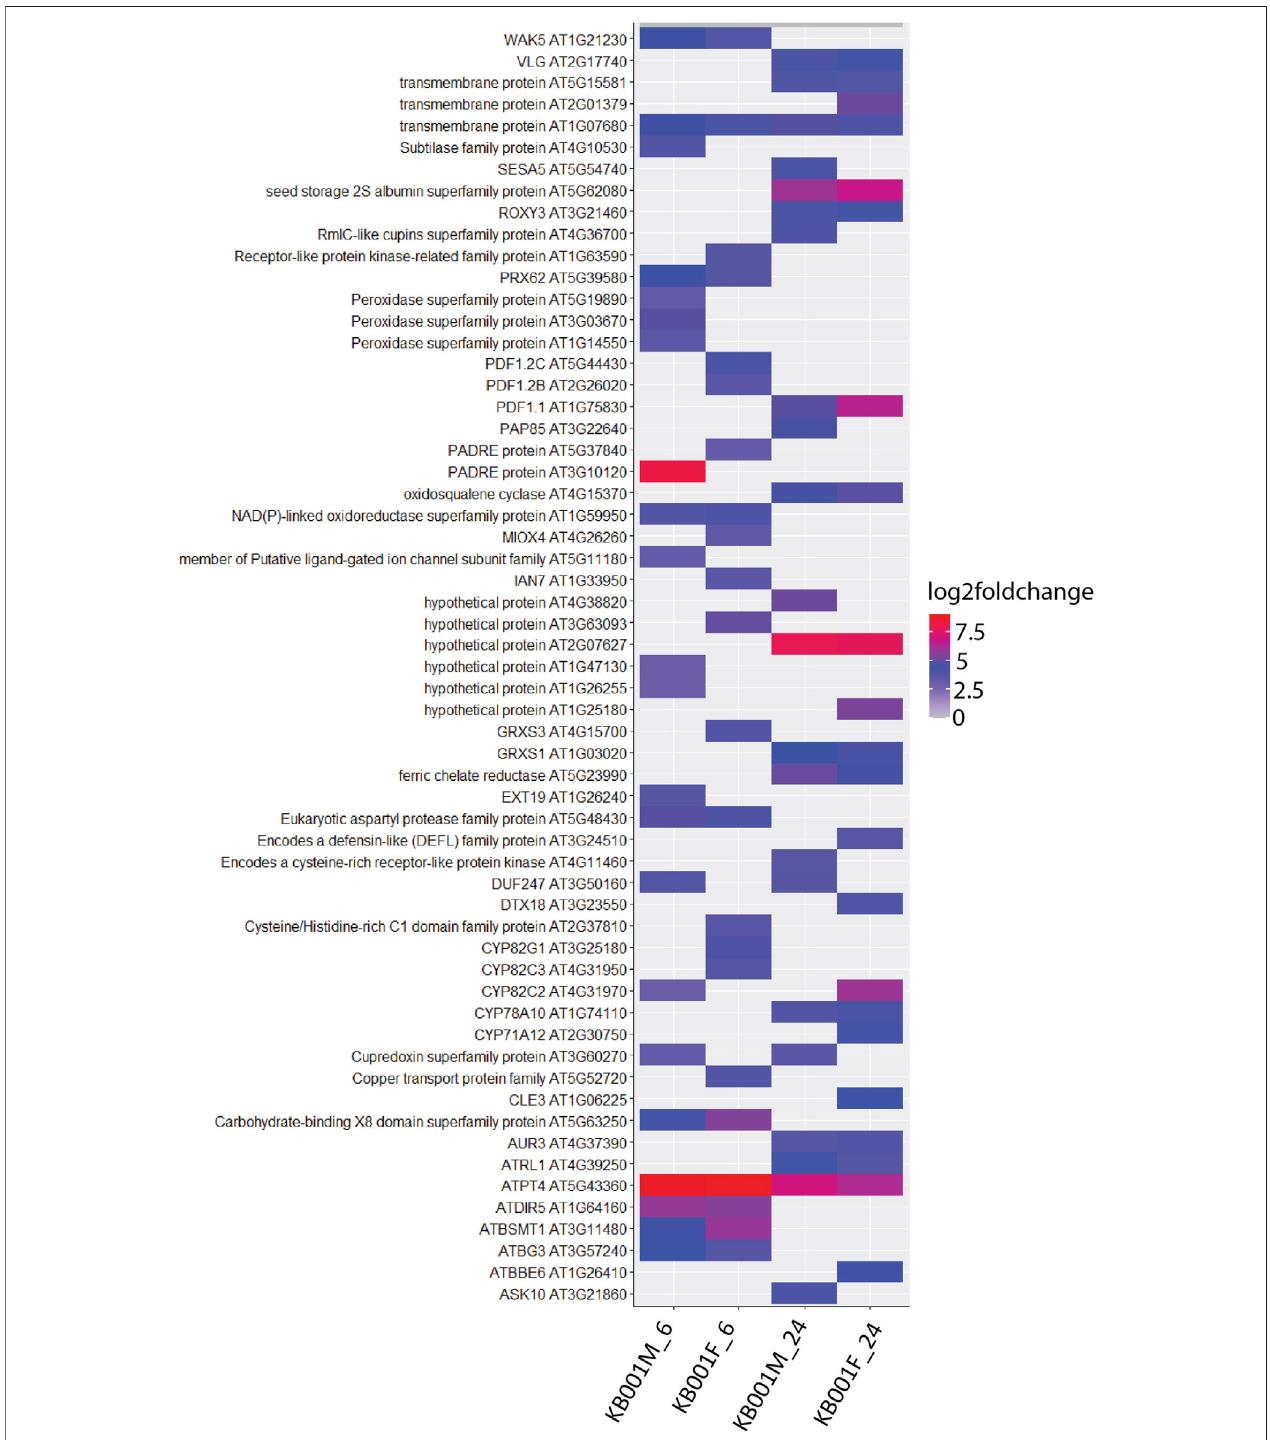
FIGURE8| HeatmapvisualisationofArabidopsisgenesupregulatedafterKB001microbial(KB001_M)andKB001culture fi ltrate(KB001_F)treatment.Shownare the most upregulated genes in Arabidopsis after treatment with KB001 compared to the nontreated control (NTC). Four biological replicates for each treatment were used. Expression of genes is given in log2 fold change to the NTC. Description of these genes can be found in Supplementary Table S5 .